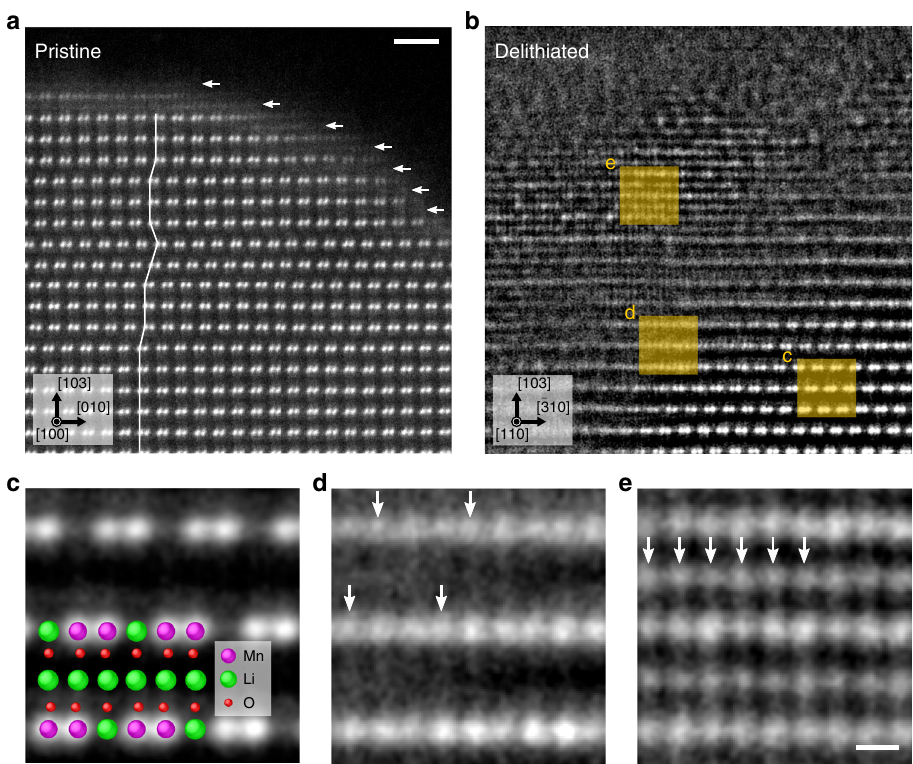
Fig. 2 Atomic structural analysis in pristine and partially delithiated Li 2 MnO 3 single crystals. HAADF-STEM images obtained from a pristine, b partially delithiated samples, respectively. The magni fi ed HAADF-STEM images of orange squared regions: c pristine, d interface, and e delithiated regions, respectively. The scale bars in a and e are 1 nm and 0.2 nm,